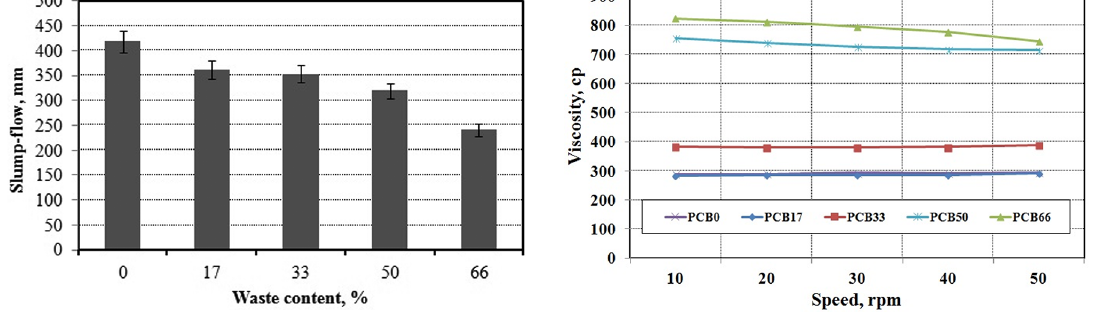
Figure 4. Slump-flow values of PCBs versus waste content. Figure 5. Viscosity of PCBs depending on deformation